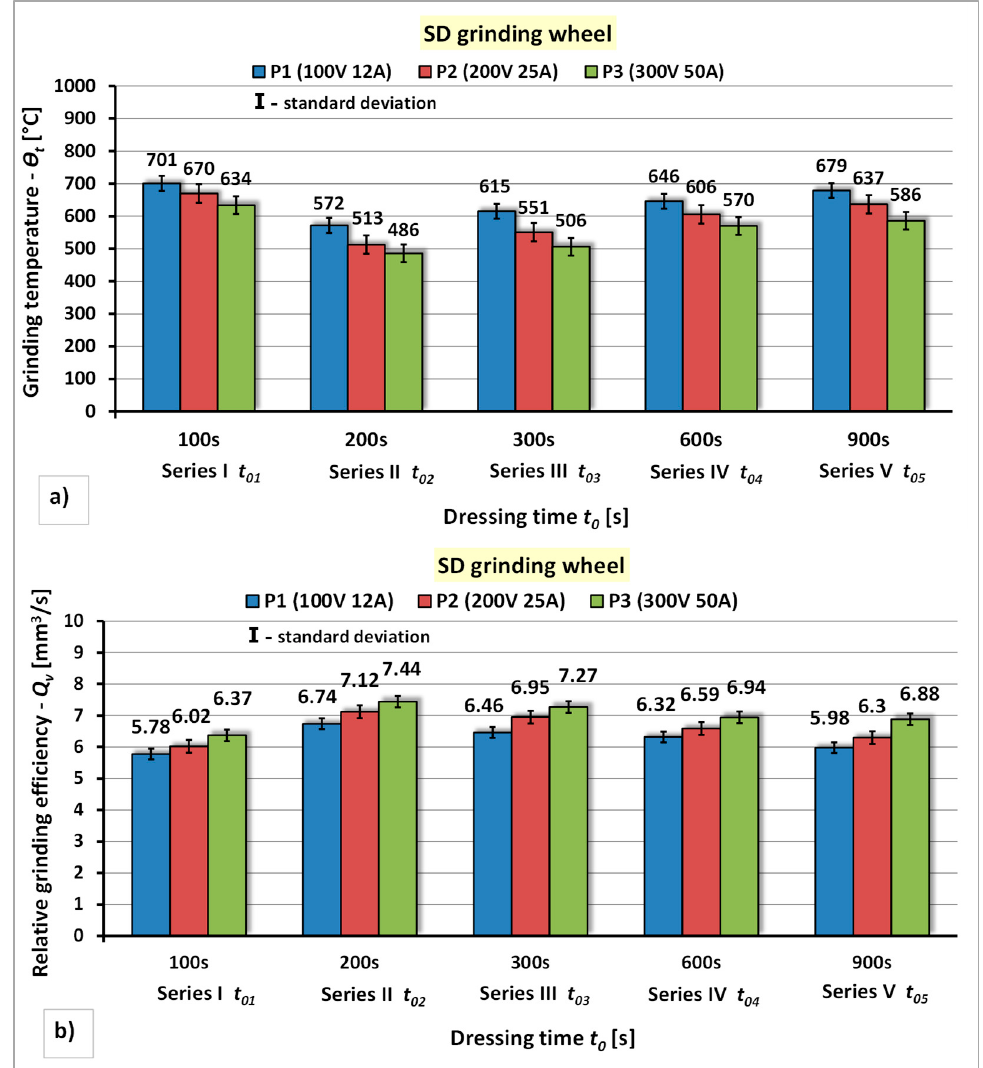
Figure 9. The effect of the generator power and unit infeed time during electrodischarge dressing of a diamond grinding wheel using a rotating electrode: ( a ) On the grinding temperature— Θ t ; ( b ) On the relative grinding efficiency— Q v .